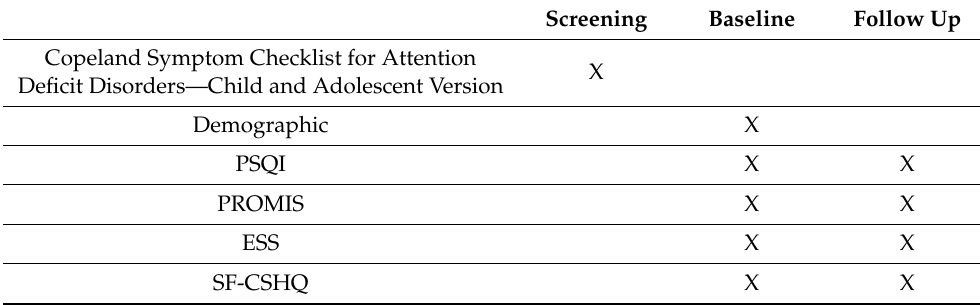
Table 2. Schedule of survey measures administered. Screening Baseline Follow Up Copeland Symptom Checklist for Attention X Deficit Disorders—Child and Adolescent Version Demographic X PSQI X